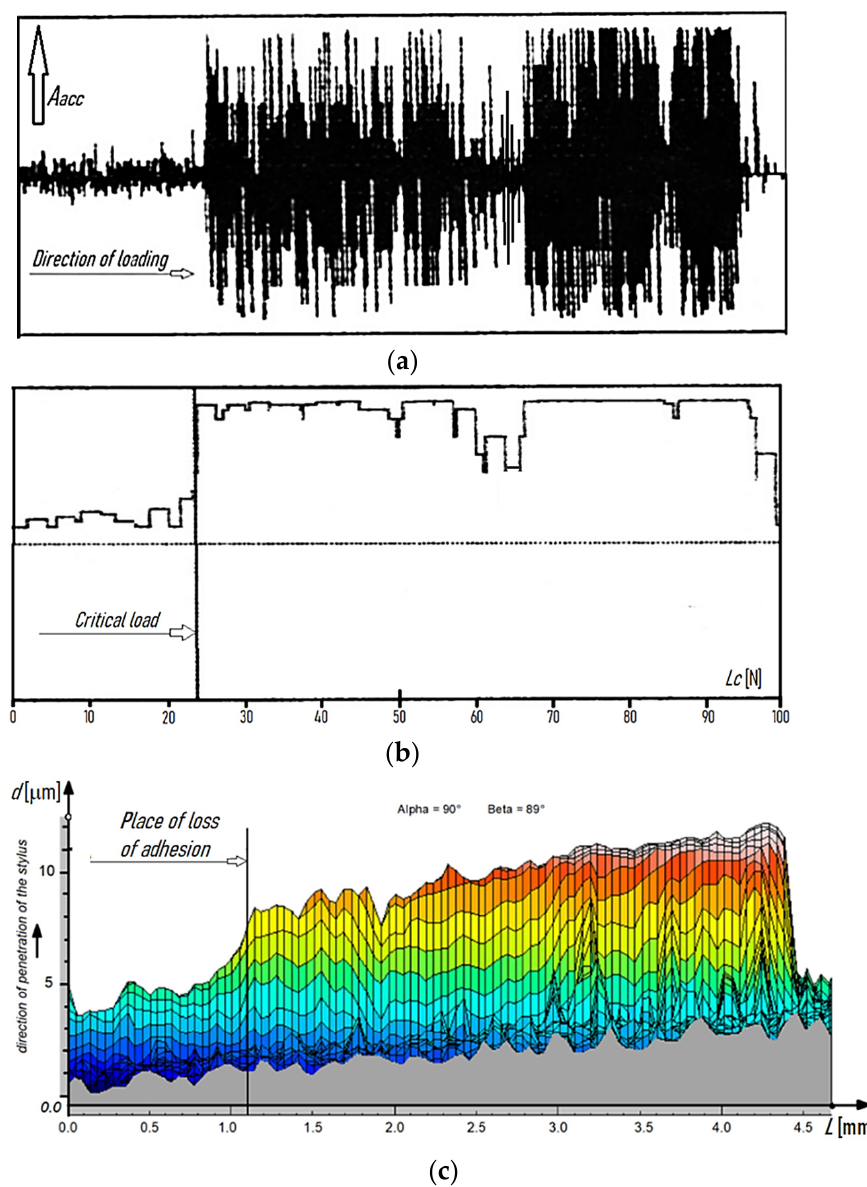
Figure 3. Examples of scratch test results obtained for the TiN coating applied to the cemented carbide cutting inserts SM25 (P15–P40, M25–M35) before laser heating: ( a ) actual value of the vibration signal (vibration acceleration signal amplitude— A acc ), ( b ) positive envelope of the vibration signal as a function of loading, and ( c ) negative image of the scratch occurring with a gradual increase in the load on the indenter.